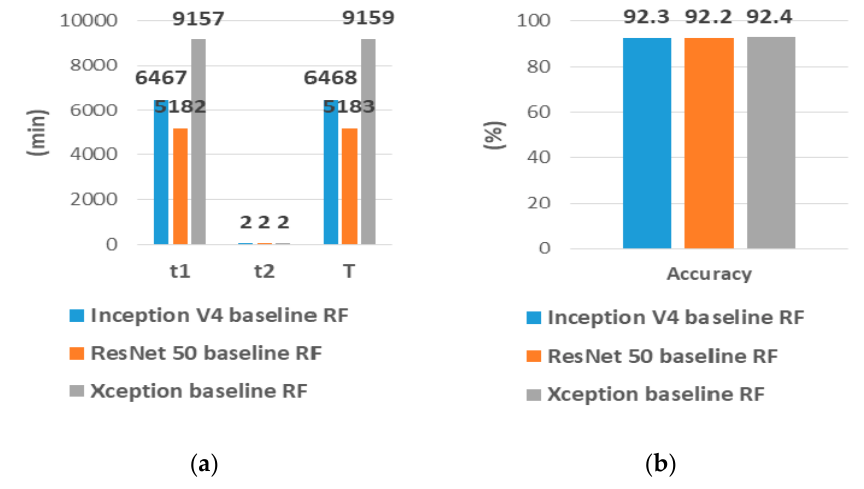
Figure 3. ( a ) Training data collection time t 1 , training time t 2 , and total time T of baseline scenario, ( b ) For each CNN model, the highest processing prediction accuracy of baseline scenario.